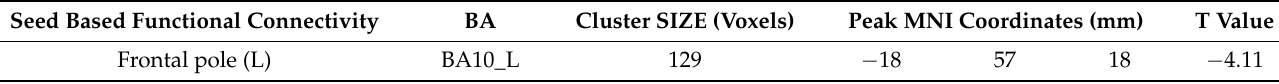
Table 3. Significant differences in the ROI-to-ROI functional connectivity between TP1 and TP2.